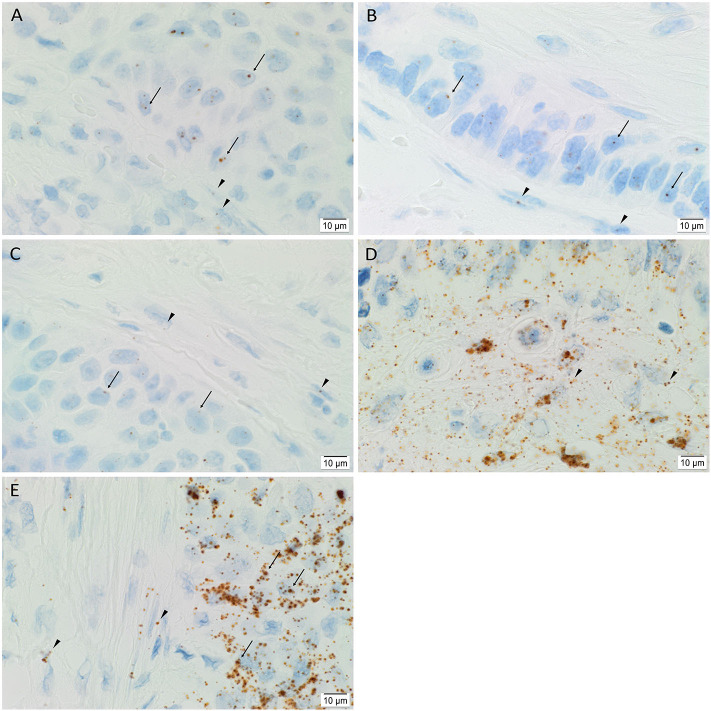
Representative in situ hybridization images of a metastatic head and neck cutaneous squamous cell carcinoma tissue sample demonstrating expression of mRNA transcripts of induced pluripotent stem cell markers. Transcripts for OCT4 (A, brown), NANOG (B, brown), SOX2 (C, brown), KLF4 (D, brown) and c-MYC (E, brown) were present throughout the TNs (arrows), and to a lesser degree, in the PTS (arrowheads). Nuclei were counter-stained with hematoxylin (A–E, blue). Original magnification: 1000x.